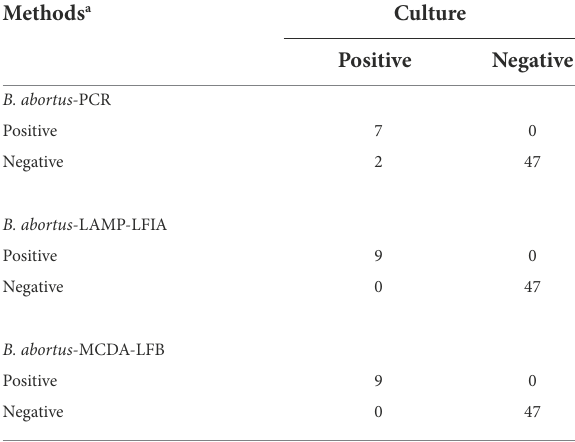
TABLE 3 Comparison of four methods for the detection of 56 whole blood samples. Methods